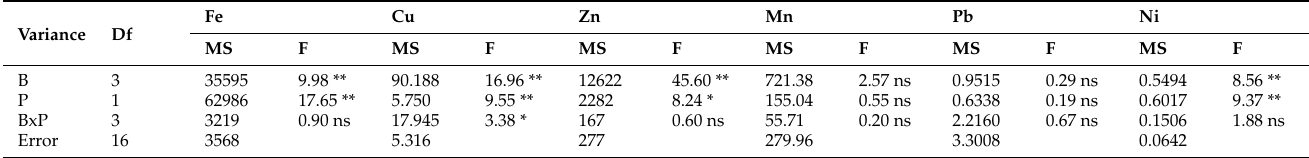
As it can be seen in Table 2, biochar (B) application had a significant effect on soil pH, salt, lime, and soil organic matter (SOM) contents at the 1% level. In comparison, PGPR applications only affected the pH at the 5% level. Only the effect of BxP interaction on soil pH was determined to be significant. Biochar applications had an effect of 5% and